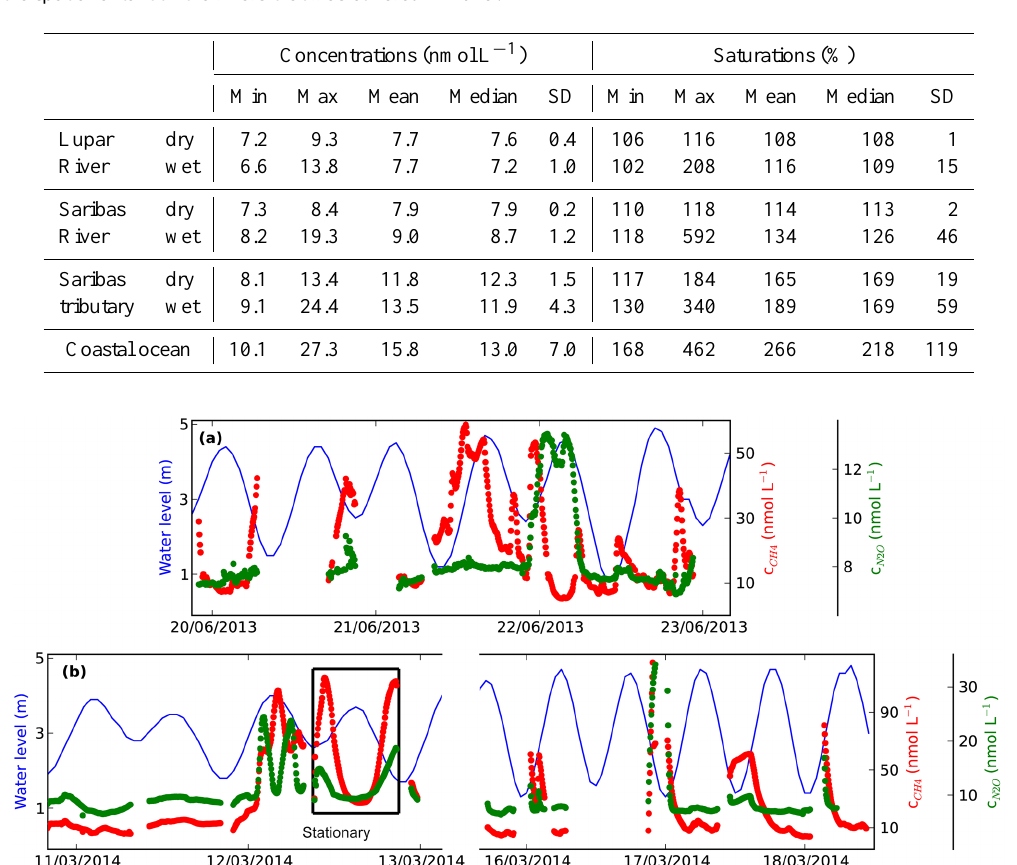
Table 2. N 2 O concentrations and saturations in the Lupar River, Saribas River, Saribas tributary, and coastal ocean. Values for the estuaries are given for the spatial extent of the rivers that was covered in 2013.